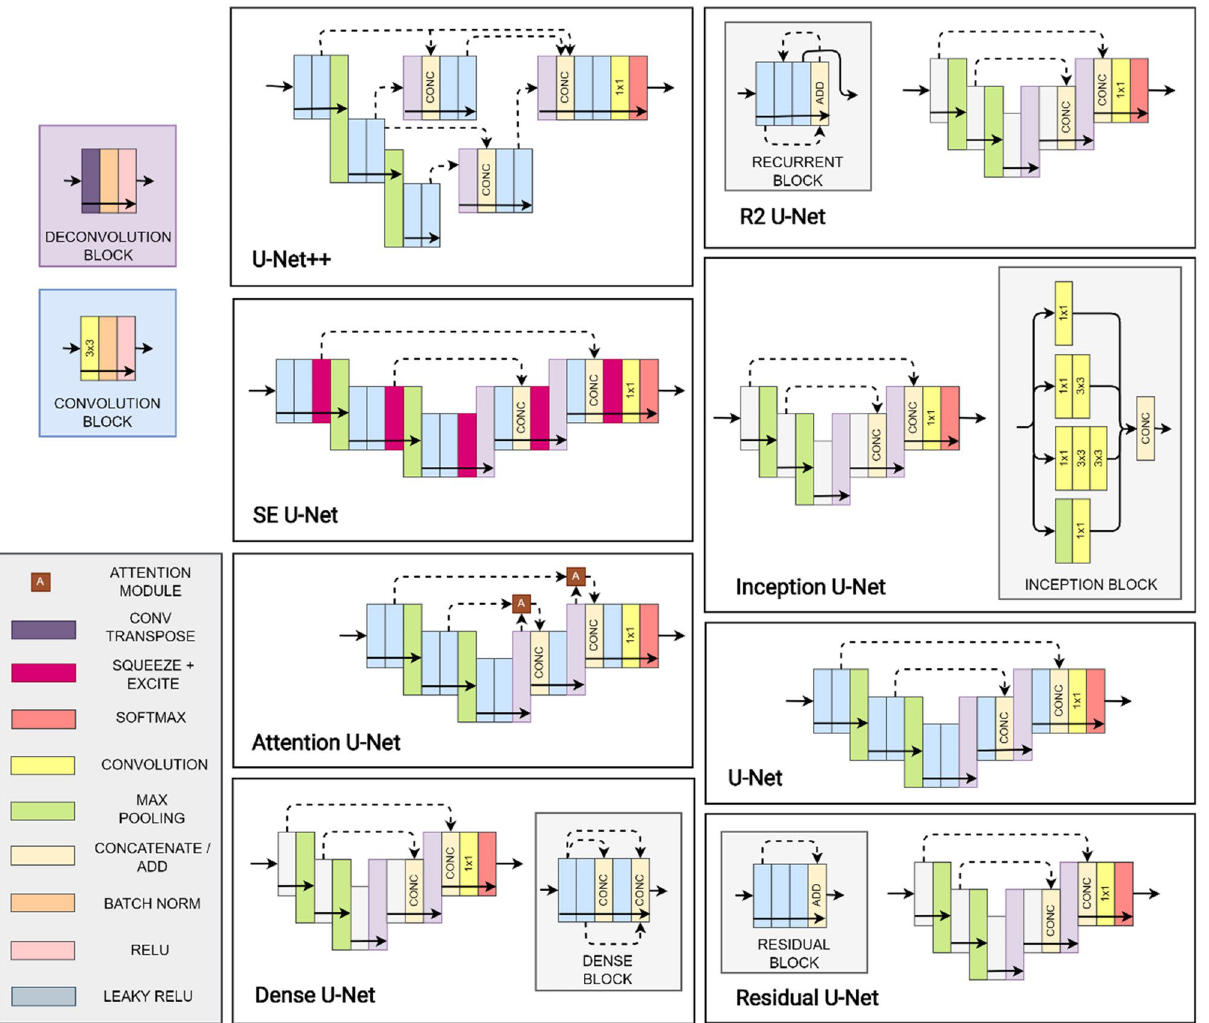
Figure 2. Summary of the U-Net based architectures compared in this study. Each architecture is depicted with two pooling layers for simplicity but each uses four pooling layers in our experiments. Arrows show direction of information flow. Coloured blocks represent particular layers as per the legend. Note: The R2, Residual and Dense variants are depicted with three convolutional layers per block (for improved visualisation) while the others are all depicted with two (except for the Inception variant where the number of layers does not